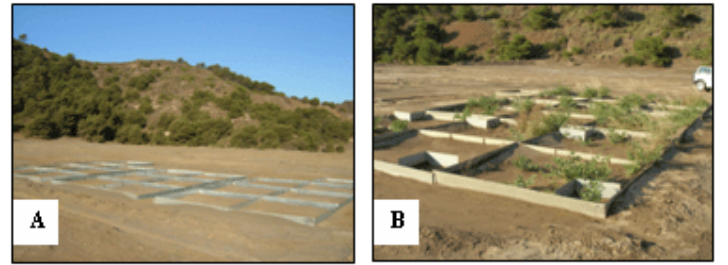
FIGURE 3. Experimental plots: (A) before amendments and (B) after 12 months of application.